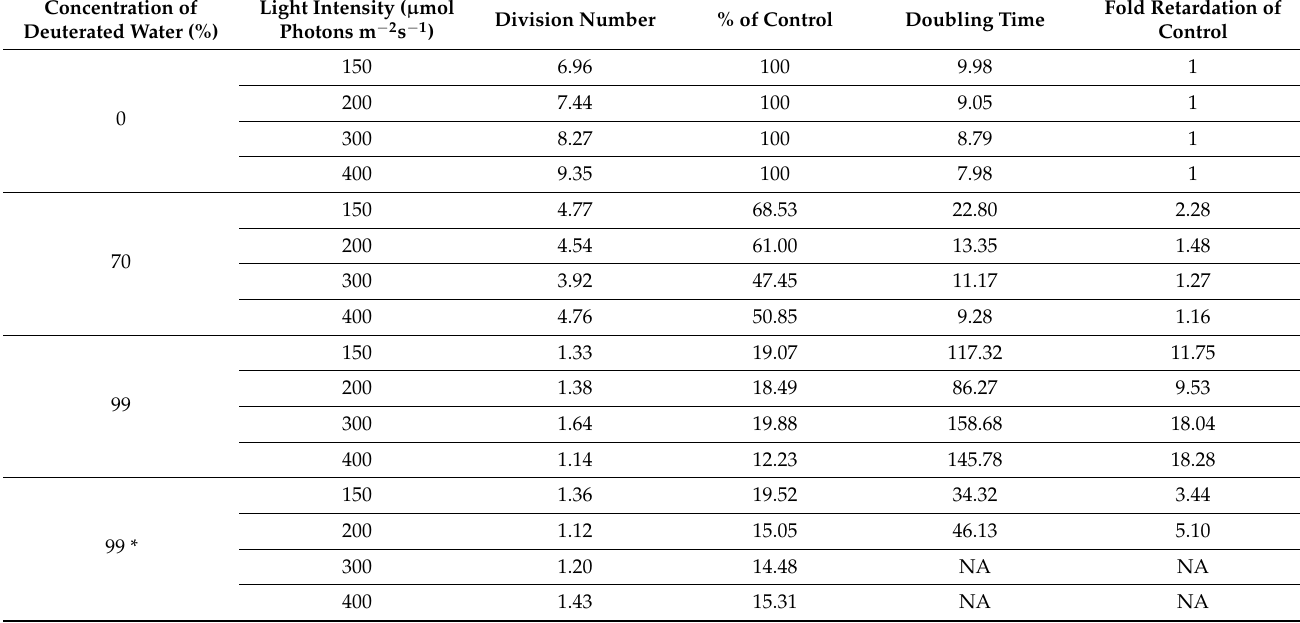
Table 1. Comparison of division number and cell number doubling times for cultures grown in medium containing different concentrations of deuterated water at different light intensities. The average of at least three experiments is shown. Asterisks (*) denote cultures pre-adapted for one week to a given concentration of deuterated water, NA, the calculations are not reliable due to cell death and